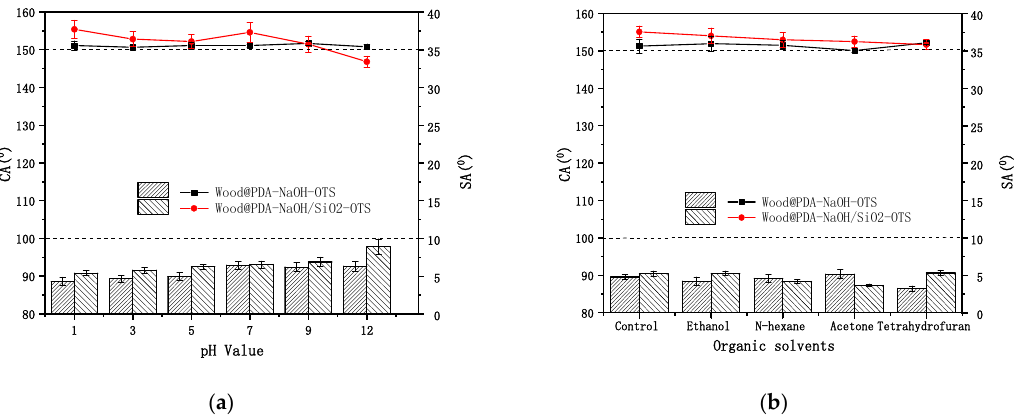
Figure 8. CAs (in lines) and SAs (in bars) of superhydrophobic wood soaked in ( a ) different pH solutions and ( b ) organic solvents for 24 h.